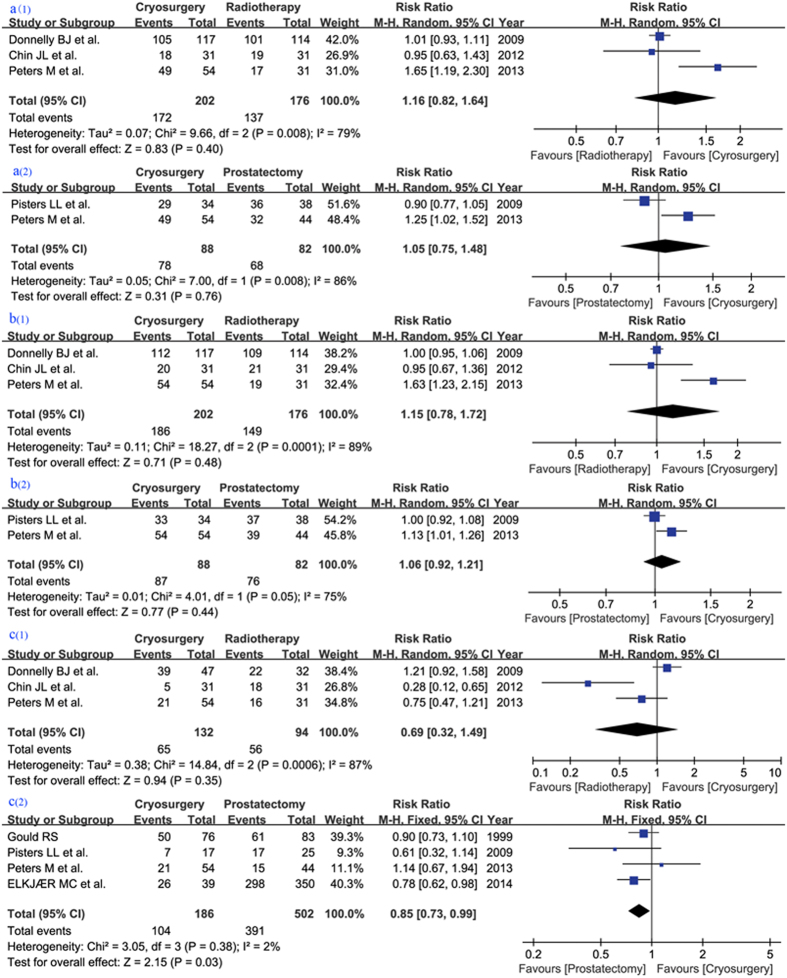
Forest plot and meta-analysis of overall survival (OS) in comparison of cryosurgery (CS) vs. radiotherapy (RT) [a(1)] and CS vs radical prostatectomy (RP) [a(2)]; disease-specific survival (DSS) in comparison of CS vs RT [b(1)] and CS vs RP [b(2)]; disease-free survival (DFS) in comparison of CS vs RT [c(1)] and CS vs. RP [c(2)].M-H = Mantel-Haenszel test. CI = confidence interval.